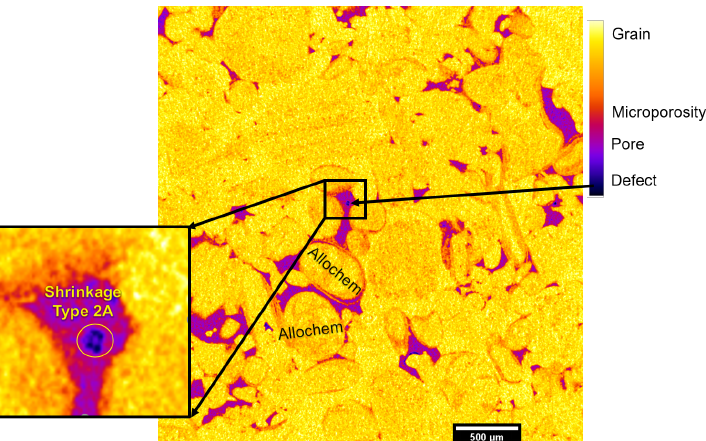
Figure 13. The micro-CT image of the Indiana limestone sample impregnated with epoxy. This grayscale image is but one of the 943 slices representing the 5.1-mm sample thickness. The sample is composed mainly of allochems as indicated; however, the microporosity geometry can hardly be identified at the resolution of 5.41 µ m per voxel. Defects, such as the highlighted type 2A shrinkage defect, could still be identified in the impregnated sample. They represent only 0.21% of the pore volume. Colors are assigned to different grayscale values to aid visualization. The color code indicates the different elements of the